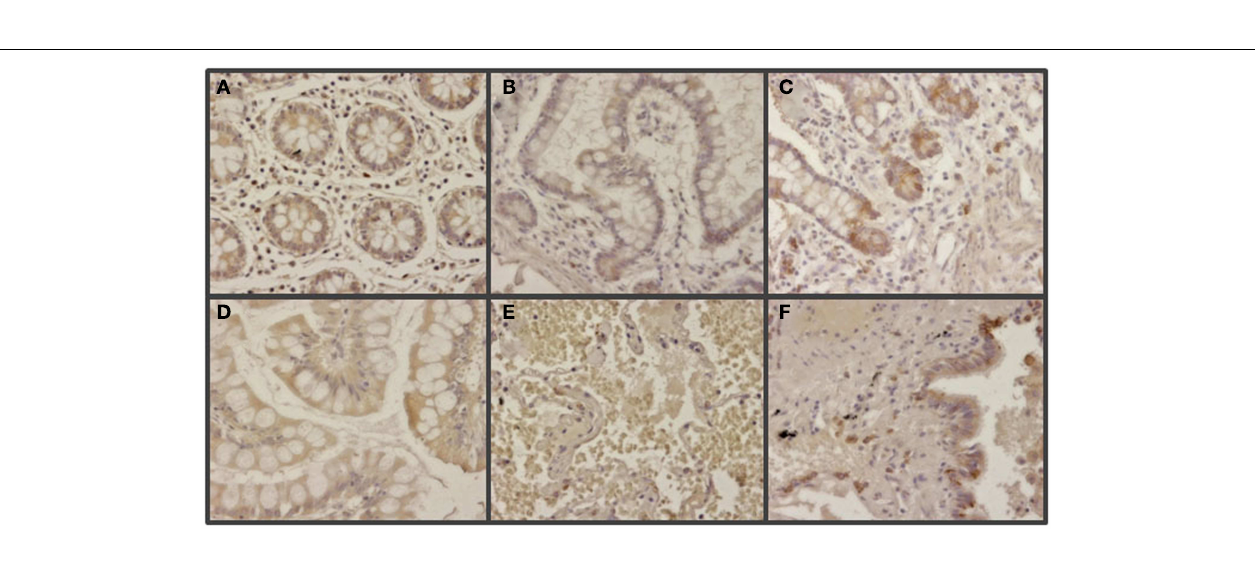
lung (E) . (C,F) Normal tissues displaying positive reaction in neuroendocrine cells from small intestine (C) , and lung (F) . Magnification 400 ×